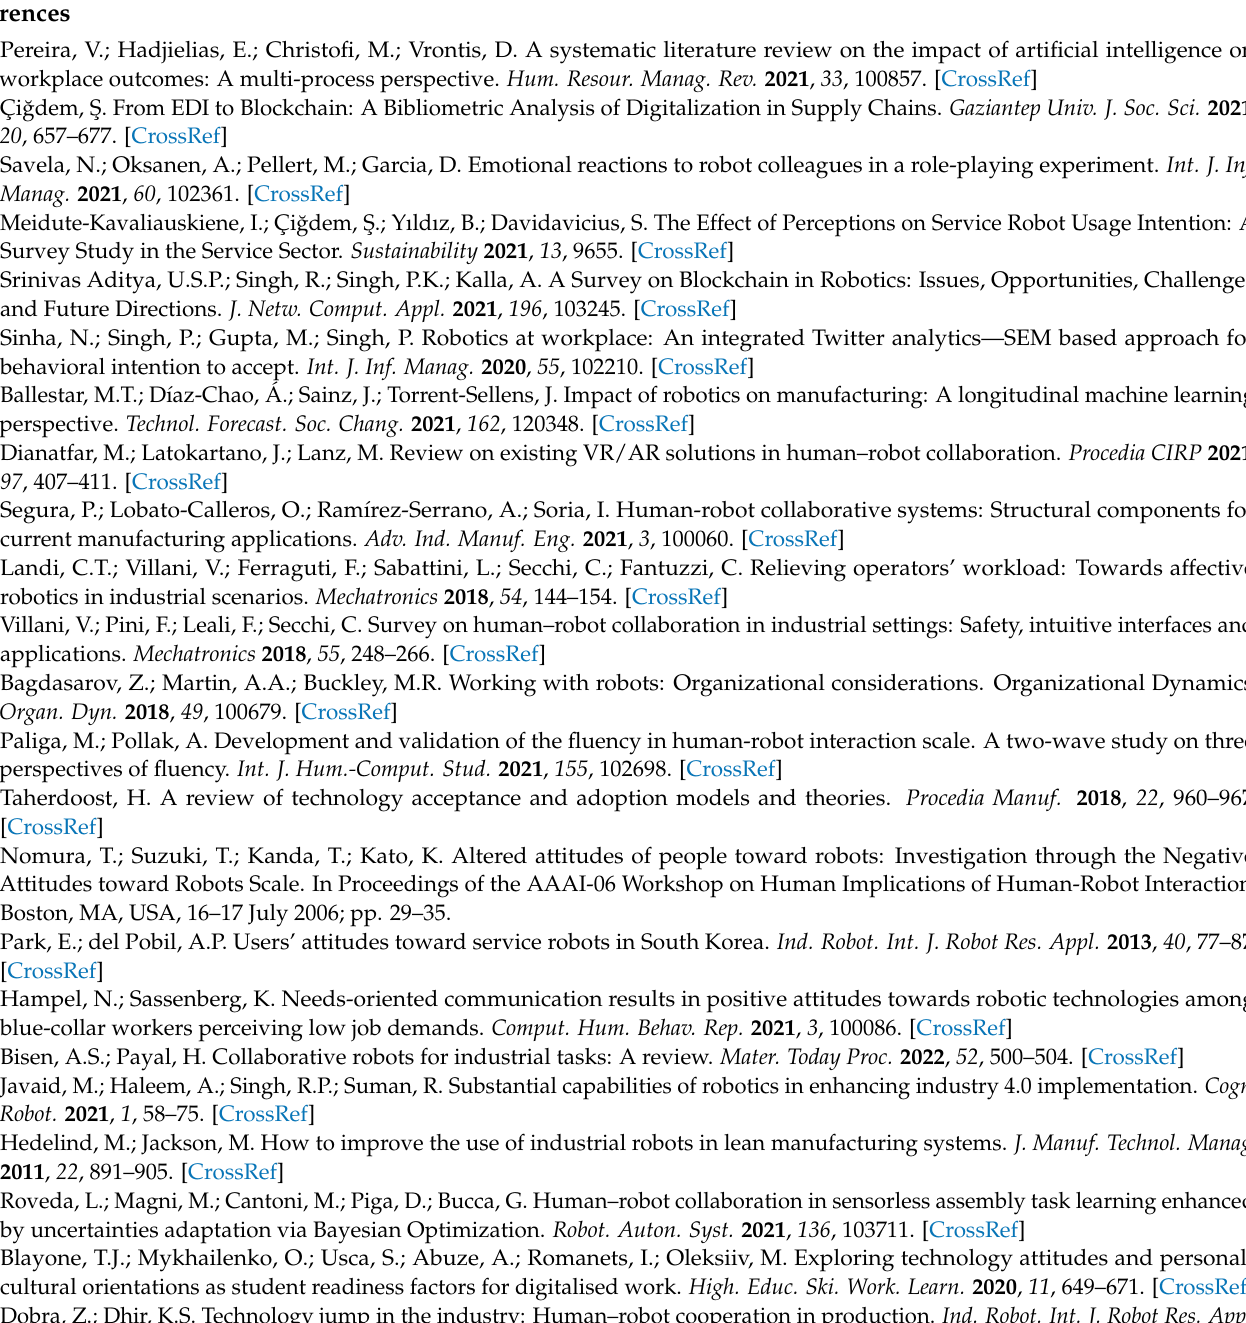
I am likely to interact with robotics in my workplace. I will feel happy to interact with robotics in my workplace. I am willing to accept robotics in my